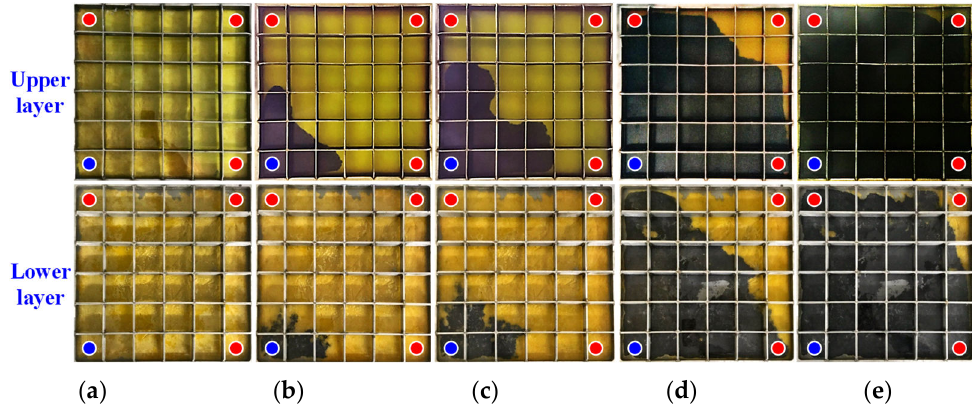
Figure 7. Sweeping field diagram of Experimental Program 2; ( a ) images of the upper and lower layers at hour 0; ( b ) images of the upper and lower layers at hour 3; ( c ) images of the upper and lower layers at hour 6; ( d ) images of the upper and lower layers at hour 12; ( e ) images of the upper and lower layers at hour 18.